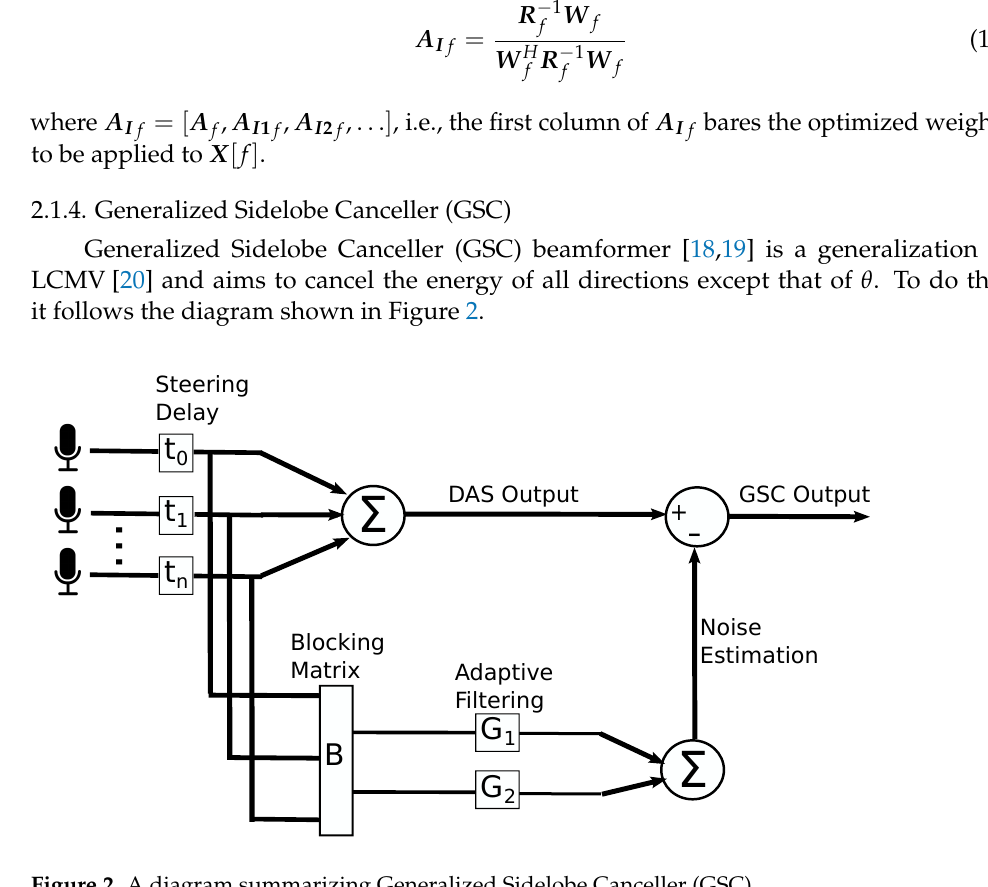
Figure 2. A diagram summarizing Generalized Sidelobe Canceller